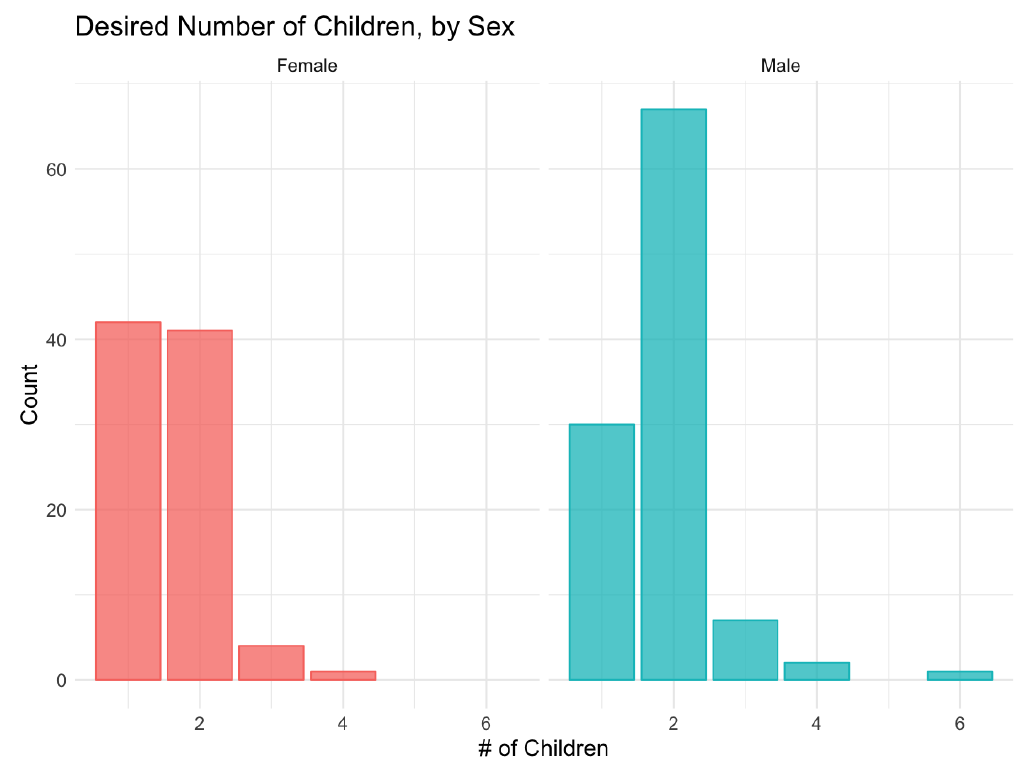
Figure 4. Total desired number of children, among those who specified a desired child count by gender of the respondent.